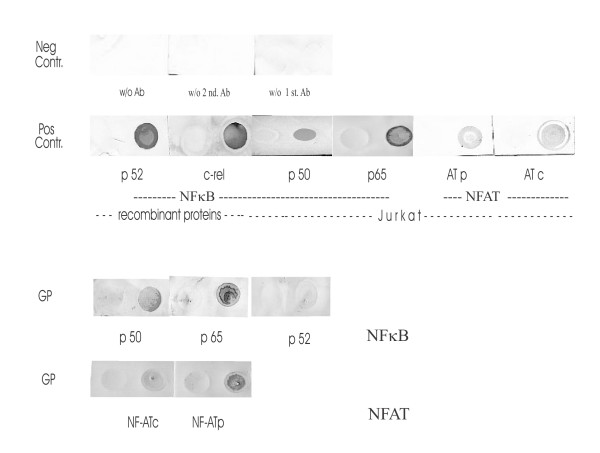
NFκB p65/p50 and NFATc2/c1 were involved in GP-induced DNA binding. In order to determine whether the DNA binding proteins activated by GP were related to NFκB and NFAT, an immuno(dot) blot was performed. A representative dot blot showing staining of negative and positive controls (recombinant proteins NFκB p52, c-rel; nuclear extracts of PMA-treated Jurkat cells positive for NFκB p50, p65 and for NFATc1, c2) in the upper panel and staining of nuclear extracts of GP-treated PBMC (positive for NFκB p65, p50 and NFAT c2, c1) in the lower panel is shown (n = 3).